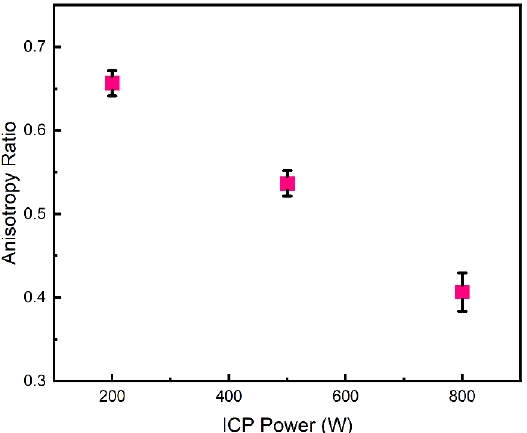
Figure 5. Anisotropy ratio of the sidewall film thickness to bottom deposition thickness for different ICP powers.